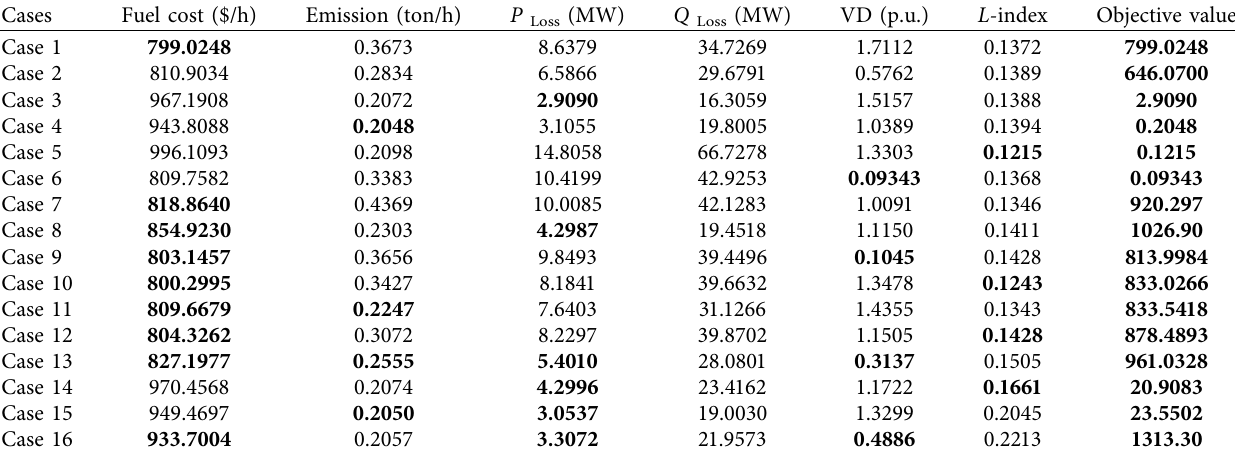
Te best objective values are highlighted in the bold